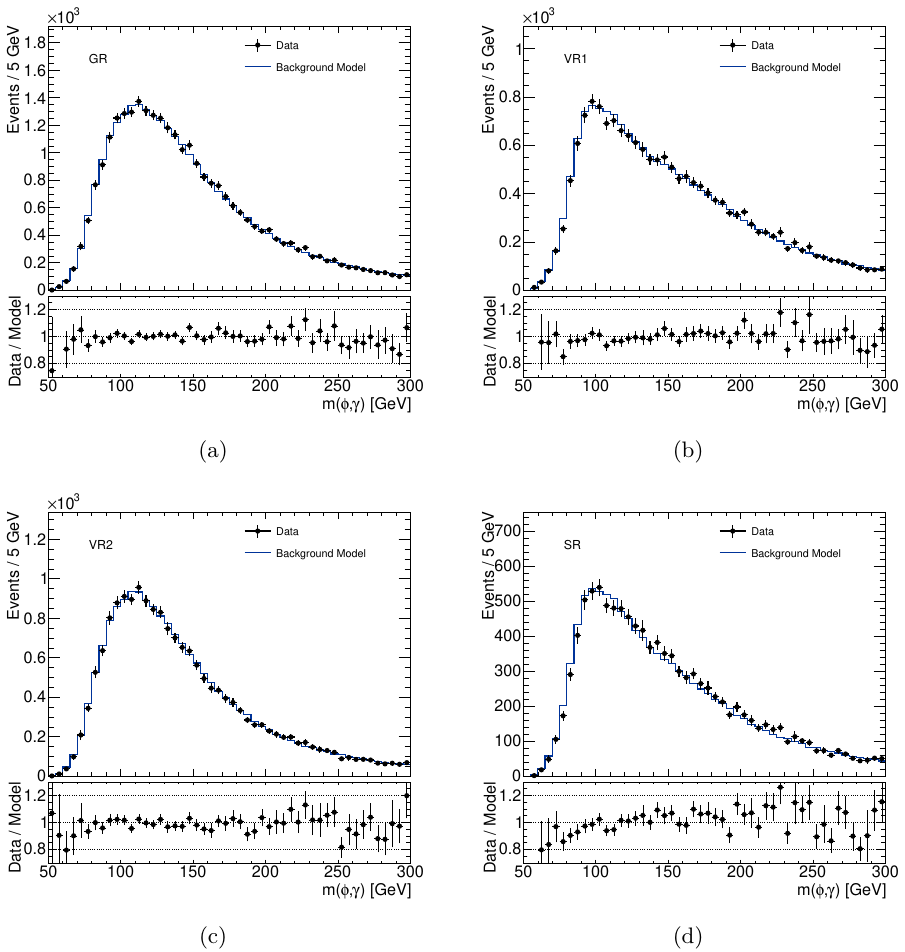
Figure 2 . m ( φ, γ ) distributions in the GR, VR1, VR2 and SR for the simulated data and background